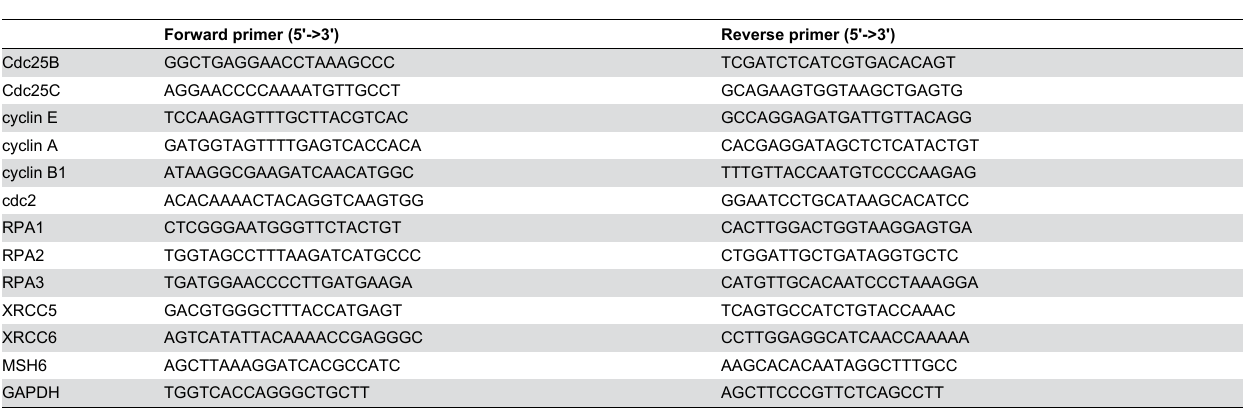
Table 1. Q-PCR forward and reverse